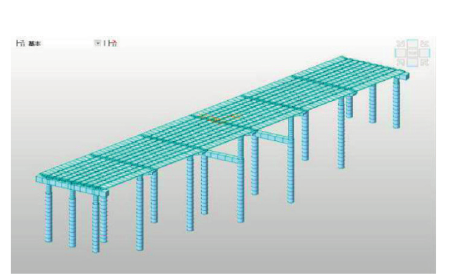
Figure 6: Bridge finite element model.